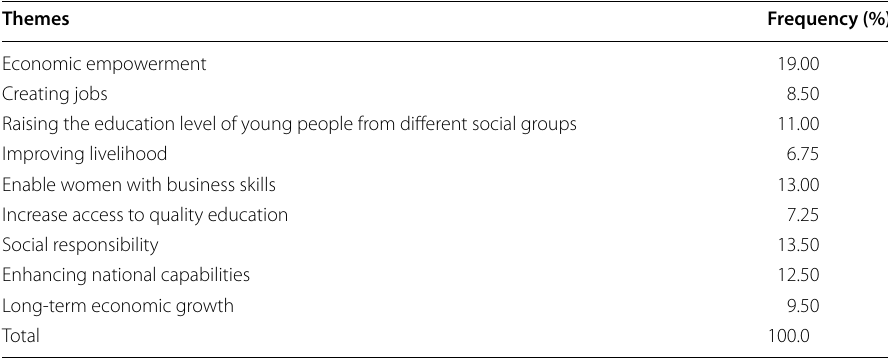
Table 6 Phenomenon negative sides’ main themes describing the organizations’ two-liner mission according to their answers Themes Frequency (%) Providing the wrong solutions 10.50 Unprofessional training 7.25 Deaccelerating the best high-impact entrepreneurs 13.00 Uninspired learning processes 11.75 Less participation 14.50 Insufficient leadership 8.25 Misleading competitiveness 10.00 Radicalized environments